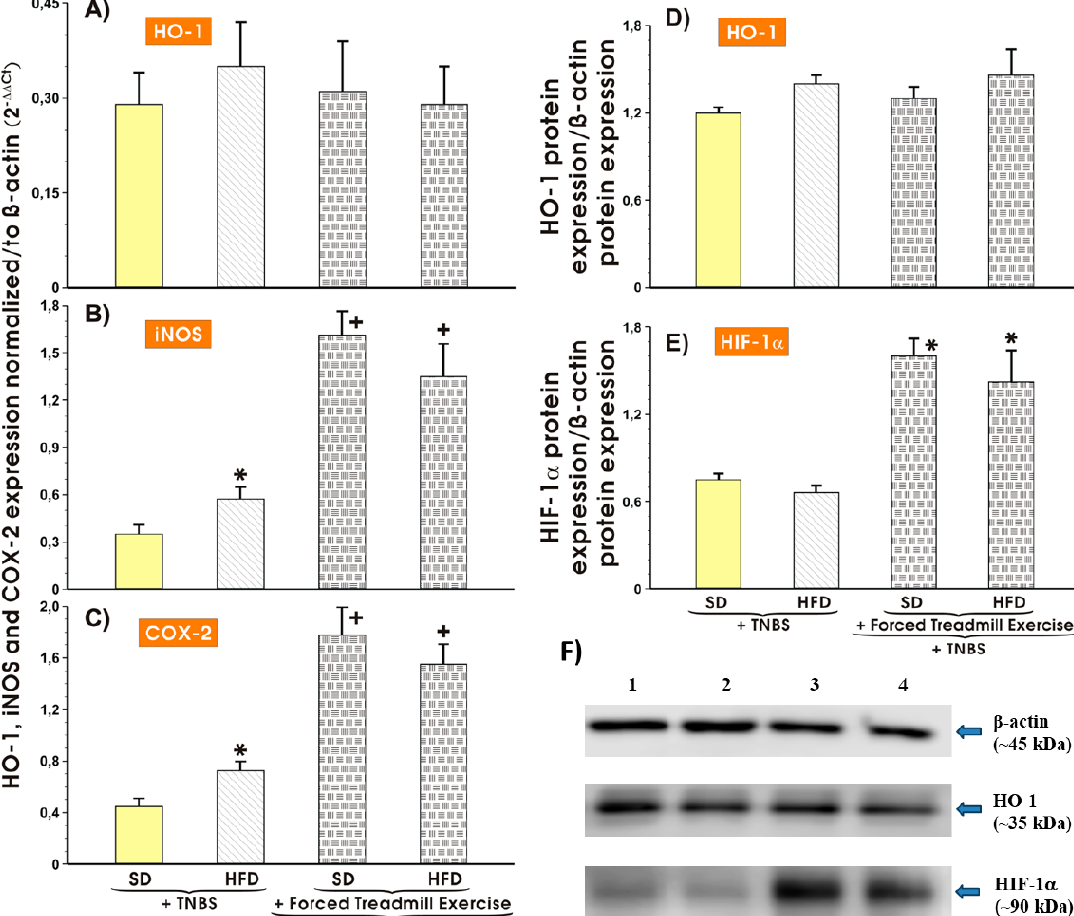
Figure 6. The e ff ect of forced treadmill exercise on the mRNA expression of HO-1 ( A ), iNOS ( B ), and COX-2 ( C ) and the protein expression of β -actin, HO-1, and HIF-1 α ( D – F ) analyzed in colonic mucosa of mice with colitis fed SD or HFD with or without forced treadmill exercise. Results are mean ± S.E.M. of 6 animals per each experimental group. Asterisk indicates a significant change ( p < 0.05) as compared with respective values in sedentary mice fed SD. Cross indicates a significant change ( p < 0.05) as compared with respective values in sedentary mice fed SD or HFD without treadmill exercise.